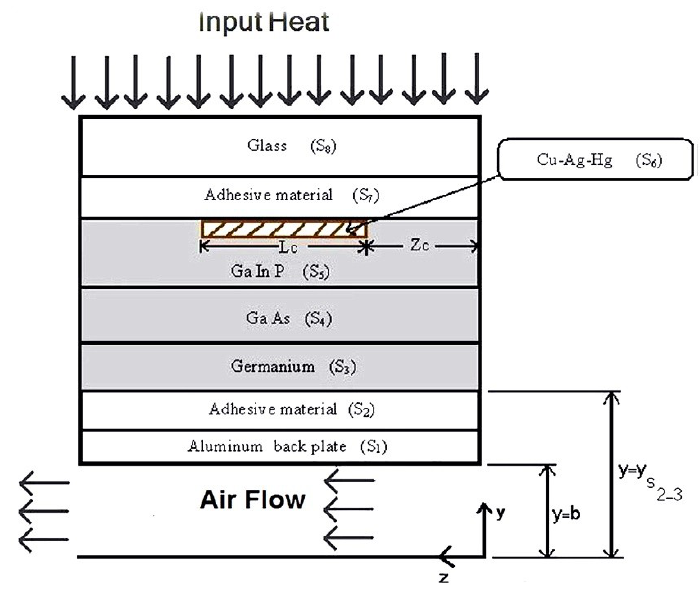
Figure 15. Schematic of the multi-junction CPV system integrated with active cooling device [87].